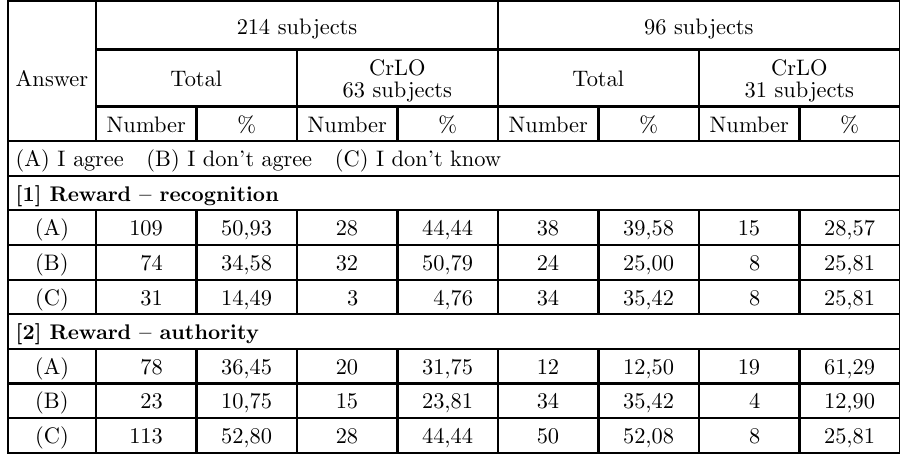
Which factors, in your opinion, determine the climate conducive to the sector creative? 214 subjects 96 subjects CrLO CrLO Answer Total Total 63 subjects 31